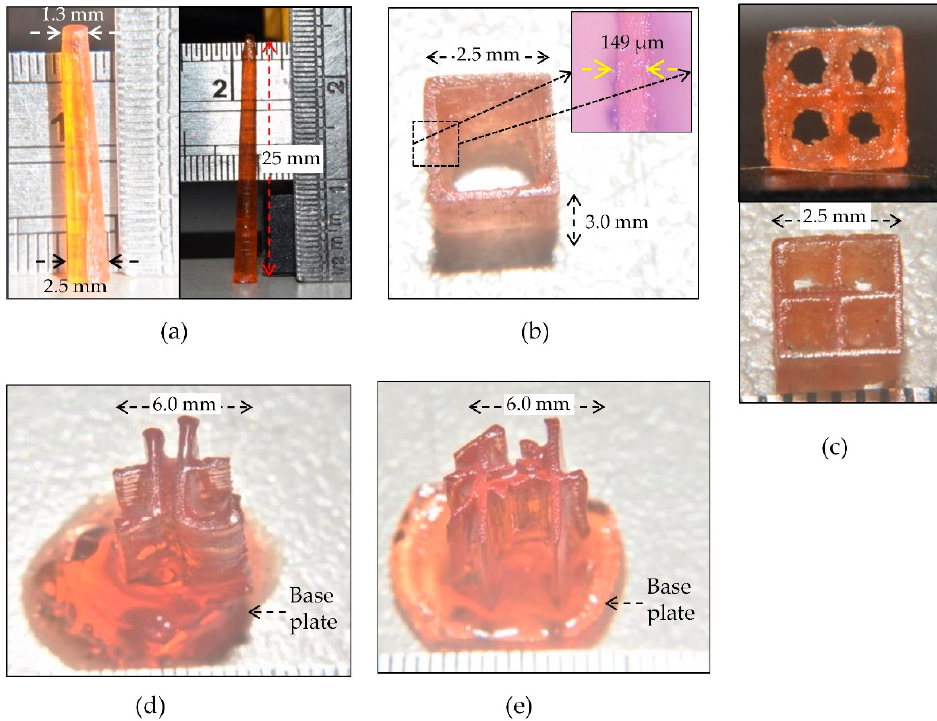
Figure 6. Five photopolymerized objects created using the proposed printing method based on holographic 3D display (3DHD): ( a ) cone; ( b ) rectangular pipe; ( c ) pipe array; ( d ) Chinese character representing “north”; and ( e ) Chinese character representing “technology.” To prevent the characters from falling apart, a base plate was formed (via photo-polymerization) at the bottom of the characters, as shown in ( d ) and ( e ).